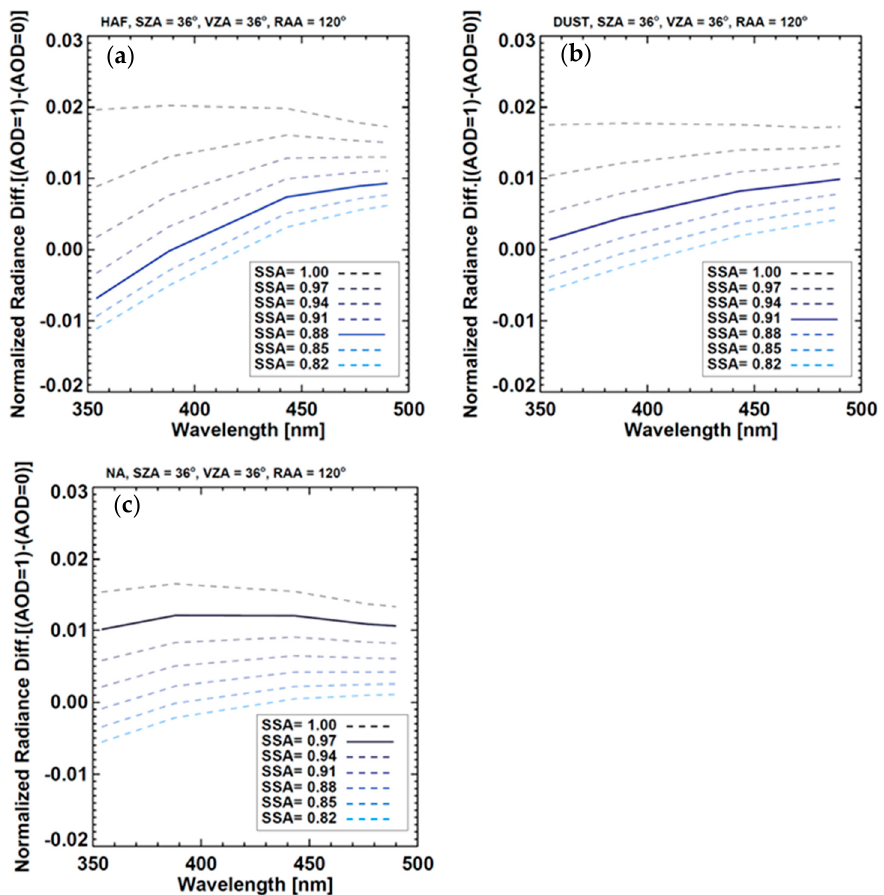
Figure 4. Spectral difference in normalized radiance (N) for pristine (AOD = 0) and polluted (AOD = 1) conditions with respect to aerosol type: ( a ) HAF, ( b ) dust and ( c ) NA. Colors indicate SSA and solid lines show the average SSA obtained from integrated AERONET inversion data for each type.